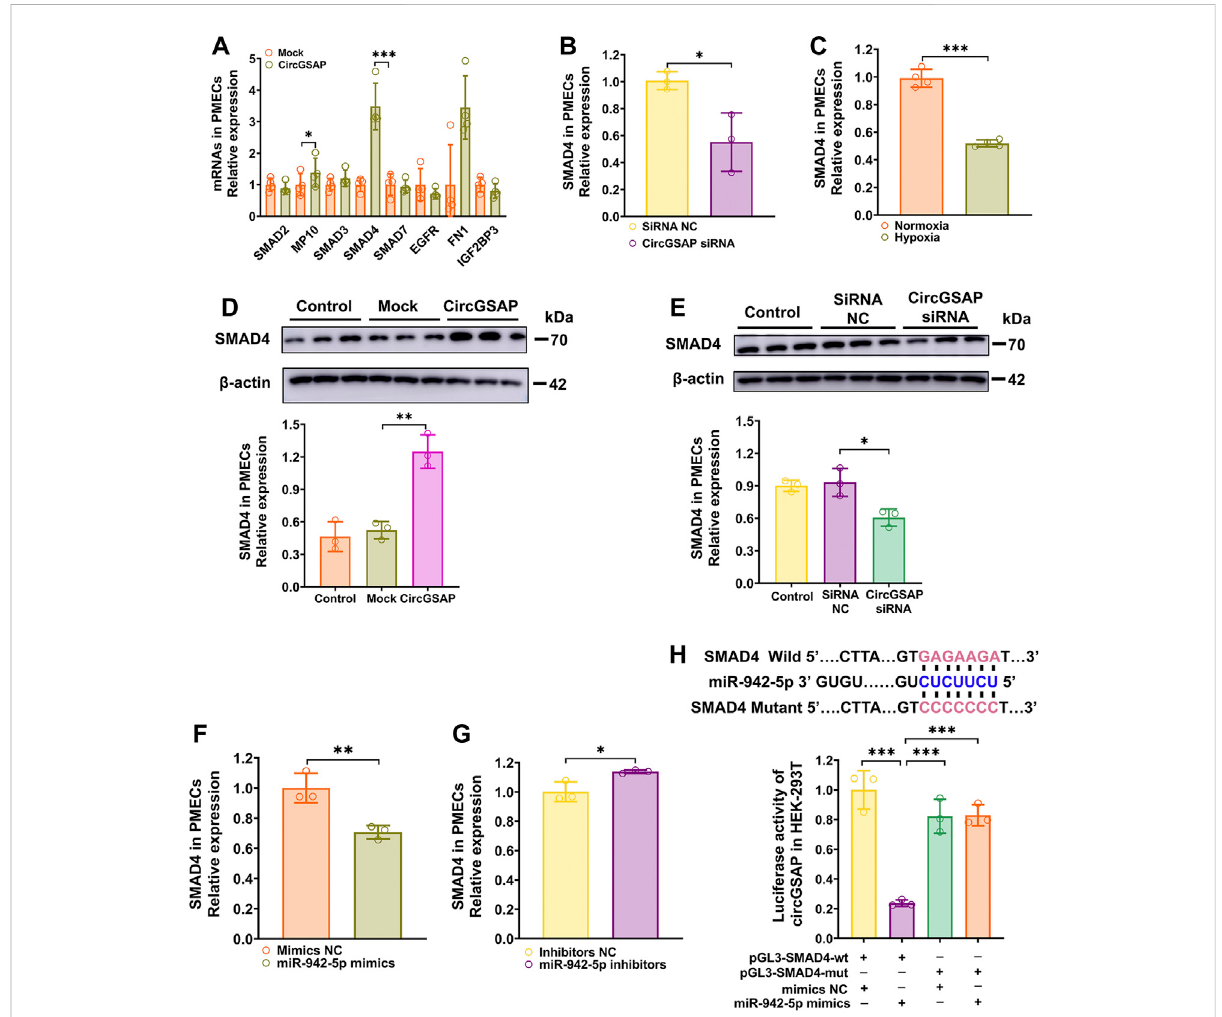
FIGURE 5 SMAD4 is The Target of miR-942-5p and is regulated by circGSAP. (A , B) Expression levels of SMAD4 in PMECs treated with circGSAP plasmid and circGSAP siRNA performed by qRT-PCR ( n = 3). (C) Expression levels of SMAD4 in hypoxia treated PMECs ( n = 4). (D , E) Expression levels of SMAD4 in PMECs treated with circGSAP plasmid and circGSAP siRNA performed by WB ( n = 3). (F , G) Expression levels of SMAD4 in PMECs treated with miR-942-5p mimics and inhibitor ( n = 3). (H) TargetScan predicted binding sites of miR-942-5p and SMAD4, and dual luciferase assays were used to validate the interactions between miR-942-5p and SMAD4 ( n = 3). All data are presented as the mean ± SEM. * p < 0.05; ** p < 0.01; *** p <